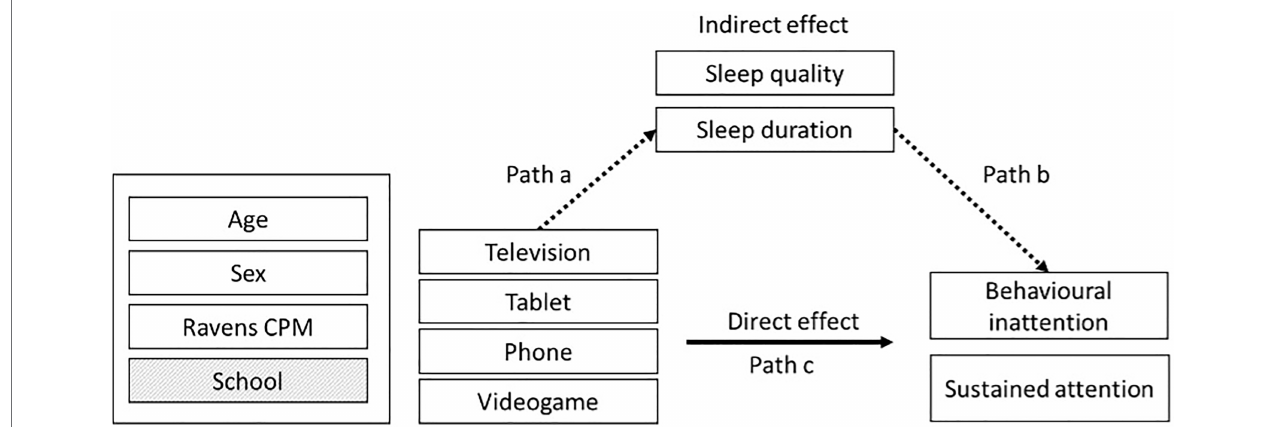
FIGURE 2 | The paths analysed in the statistical